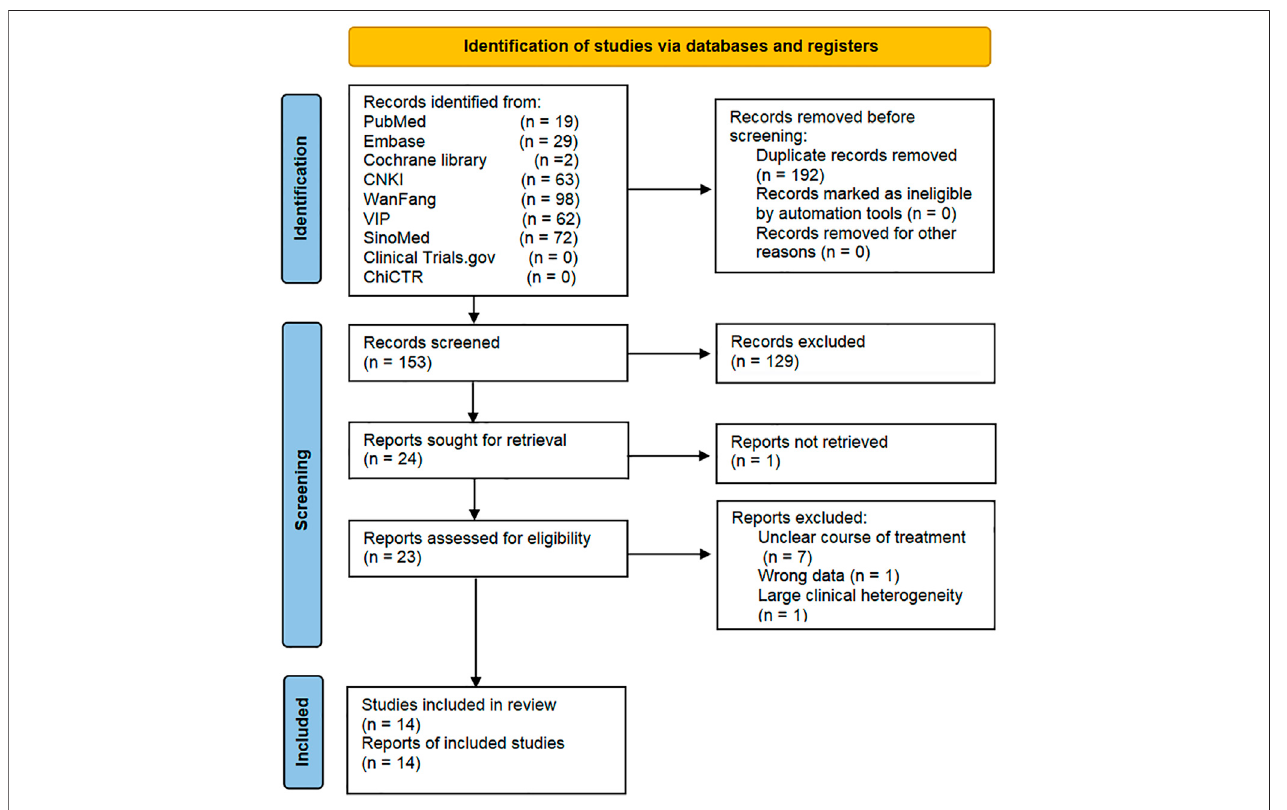
FIGURE 2 | Flow diagram for identi fi cation of